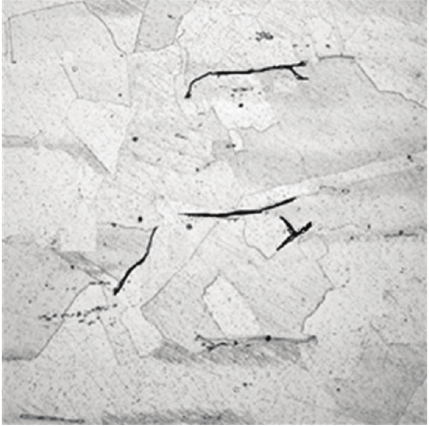
Figure 6: Austenitic stainless steel type 304NH (80 𝜇 m) showing a very slight stress corrosion cracking and few small pits.